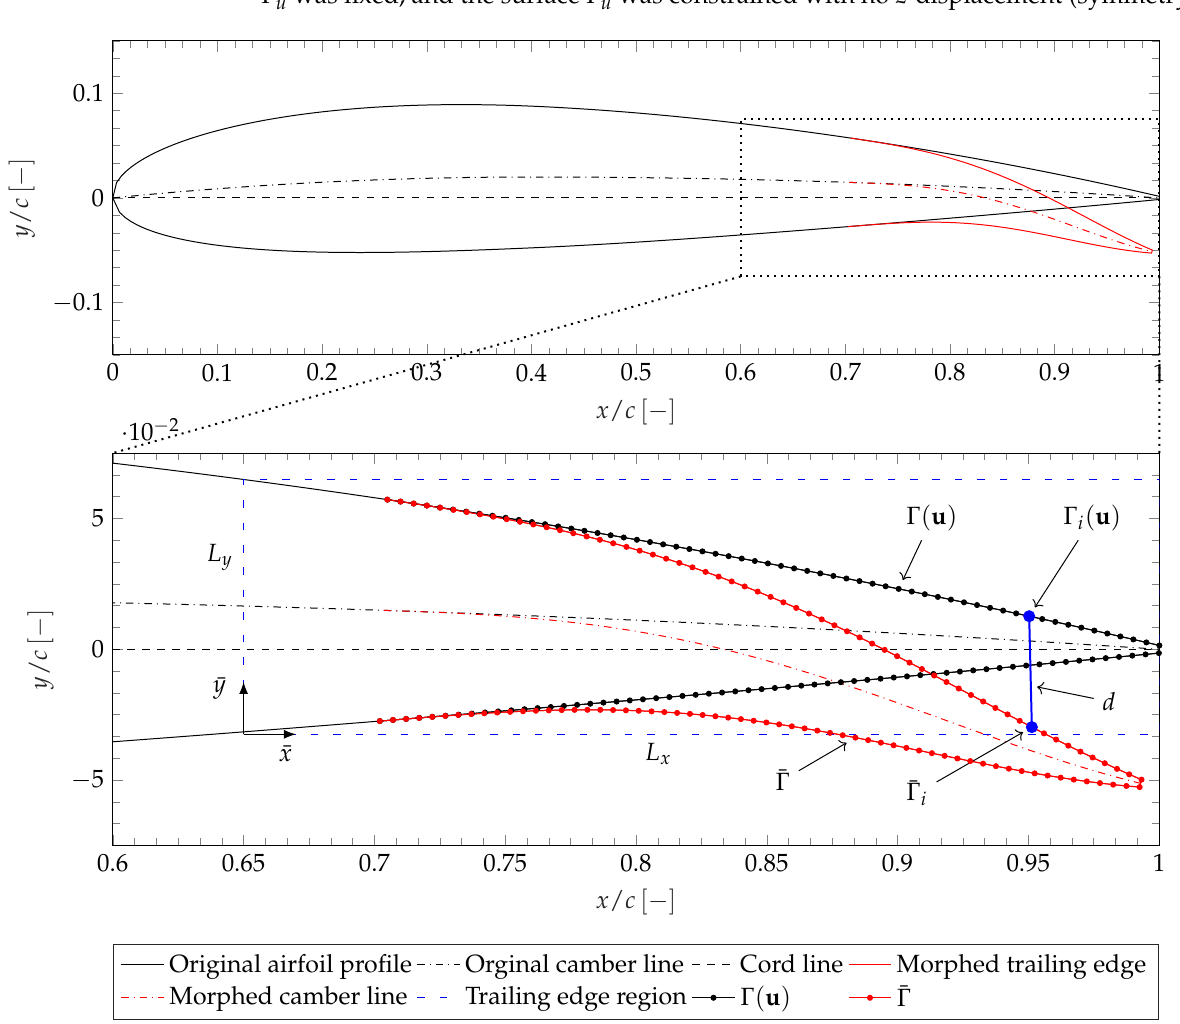
Figure 2. An NACA 2414 2D airfoil profile is illustrated with the morphed trailing edge (red line). ( ¯ x , ¯ y ) defines the reference coordinate system for the trailing edge region (blue dashed line), with the dimensions L x × L y . The trailing edge section is highlighted; here the nodal points of the original profile, Γ ( u ) , and the nodal target points, ¯ Γ , are shown. The blue line and dots show the error as the distance, d , for the node and target i .